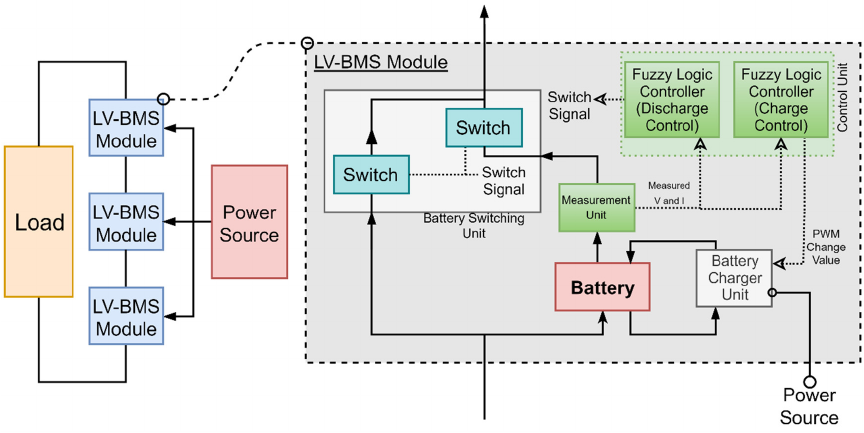
Figure 1. Low voltage battery management system (LV-BMS) block diagram.